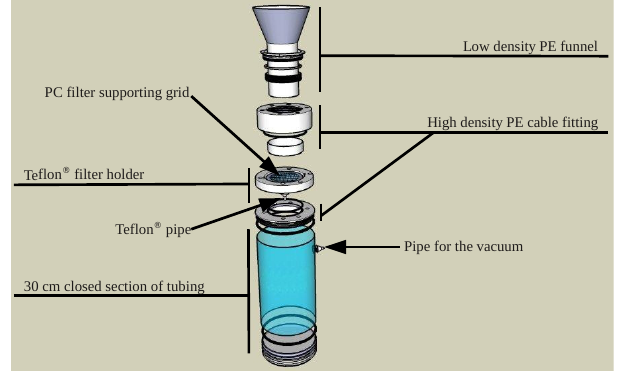
Fig. 2b. Drawing of the sampling device, the sampling funnel is cut